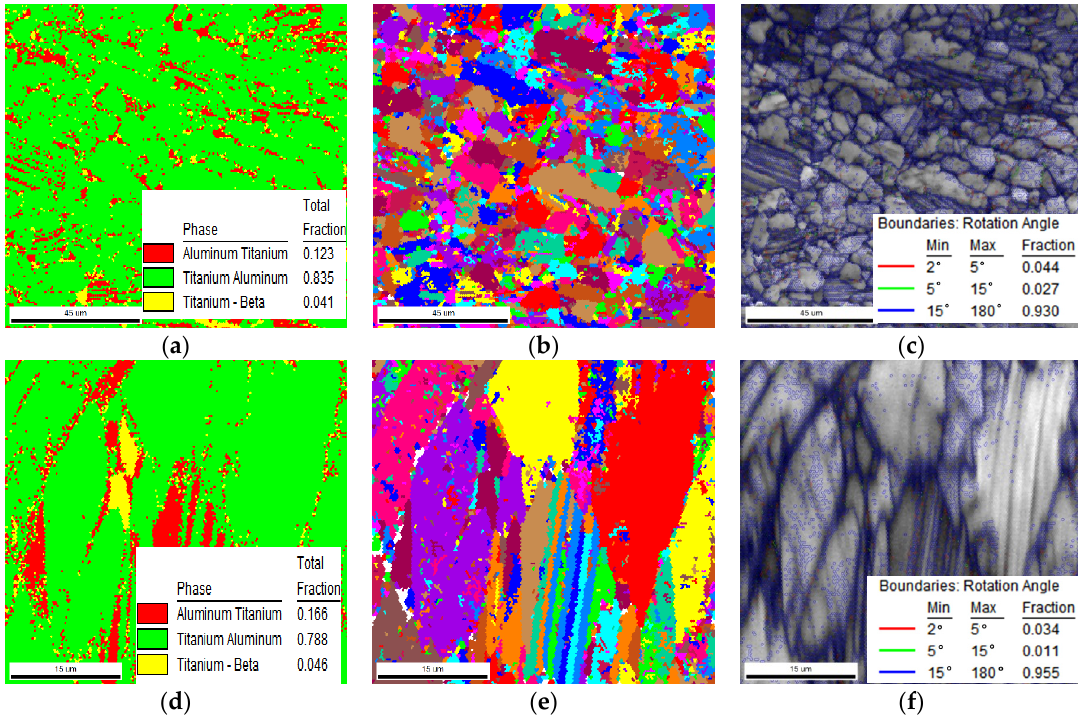
Figure 10. Electron back scatter diffraction (EBSD) maps of the forged blade: ( a ) phase distribution of center position; ( b ) grain distribution of center position; ( c ) grain misorientation angle of center position; ( d ) phase distribution of edge position; ( e ) grain distribution of edge position; ( f ) grain misorientation angle of edge position.